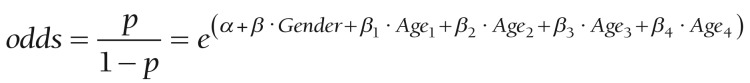
Gender- and age-specific prevalence of peripheral artery disease (PAD) based on the informative data points from the included studies The size of each bubble is proportional to sample size.